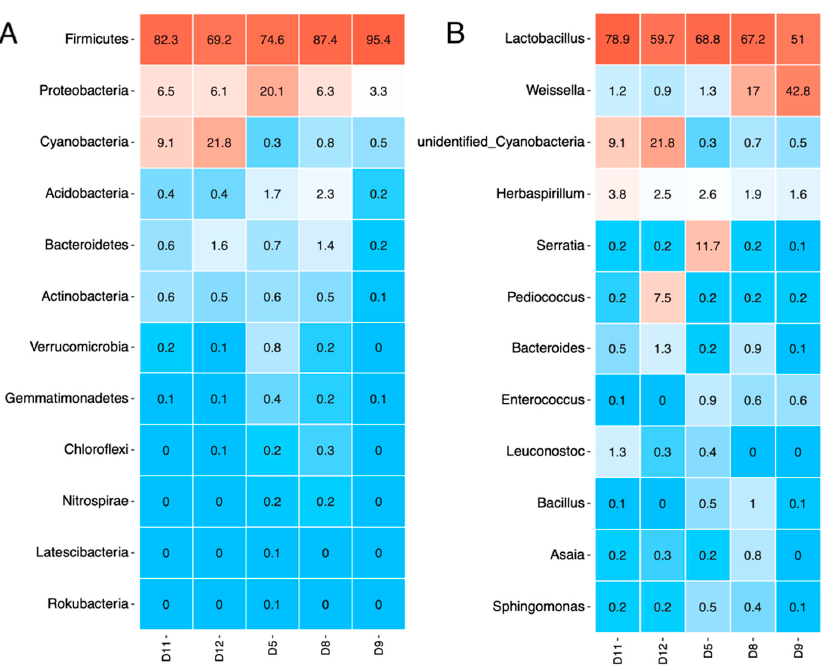
Figure 2. Taxa relative abundance at the phylum level ( A ) and genus level ( B ) in the studied sourdough samples.